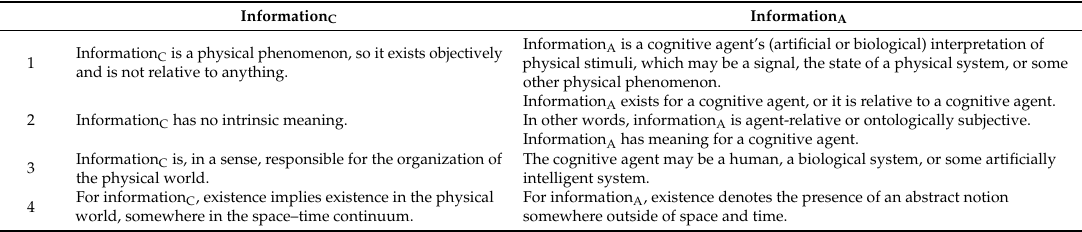
Table 1. Main properties of information A and information C